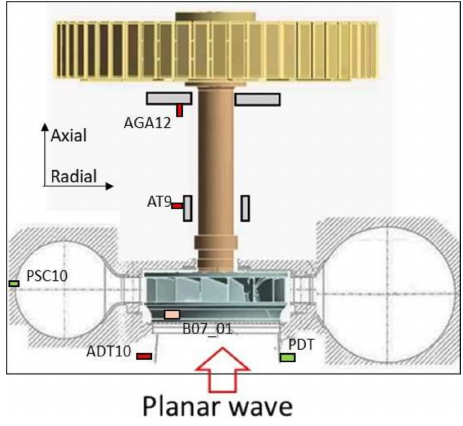
Figure 4. Sensors used for the full load instability analysis. Table 1. Main characteristics of the sensors installed: ADT 10, AT 9, AGA 12, PSC 10, PDT 10,